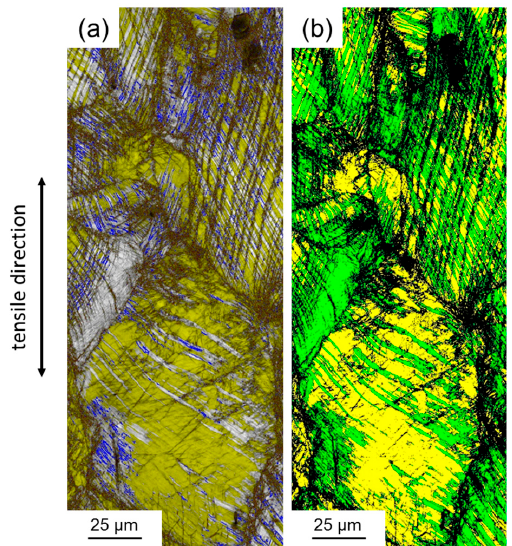
Figure 10. ( a ) Image quality EBSD map overlain by a phase map only including ε -martensite, α ’-martensite, and Σ 3 grain boundaries and ( b ) EBSD phase map of a X30Mn22 after conventional processing and tensile deformation until fracture. The color-coding is the same as in Figure 6. (In contrast to the measurements on the SLM samples, this measurement has been performed using a DigiView III camera, OIM V. 5.2, and 25 keV electron energy—the comparability to the newer measurements at this scale, however, was not affected by the different settings). Table 2. Mechanical properties of the investigated steel. YS, UTS, and e pl denote yield strength, ultimate tensile strength, and total plastic elongation, respectively.